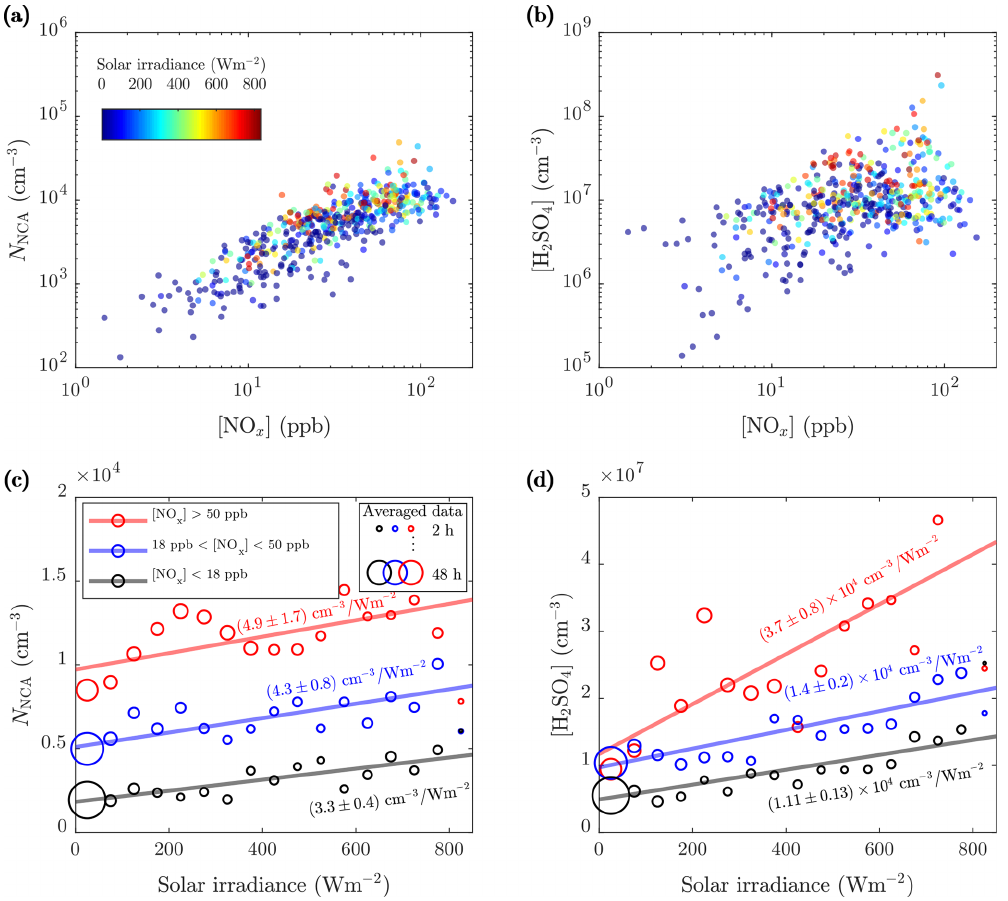
Figure 6. The 1h averages of the (a) NCA and (b) H 2 SO 4 concentrations as a function of the NO x concentration colored by the solar irradiance (SI) and 10min averages of the (c) NCA and (d) H 2 SO 4 concentrations further averaged to 17 different SI bins (bin width is chosen to provide clear graphical representation) for three NO x concentration ranges. Weighted least-squares fitting, with data point count in bin averaging (shown with the circle diameters) as weights, for the bin-averaged values was performed to output linear fits. The slopes are marked in the figure and are not largely affected by the chosen bin width. The intercepts are (c) ( 0 . 182 ± 0 . 013 ) × 10 4 , ( 0 . 51 ± 0 . 03 ) × 10 4 , and ( 0 . 97 ± 0 . 07 ) × 10 4 cm − 3 and (d) ( 0 . 49 ± 0 . 04 ) × 10 7 , ( 0 . 97 ± 0 . 06 ) × 10 7 , and ( 1 . 2 ± 0 . 3 ) × 10 7 cm − 3 for the lowest, the middle, and the highest NO x concentration ranges,